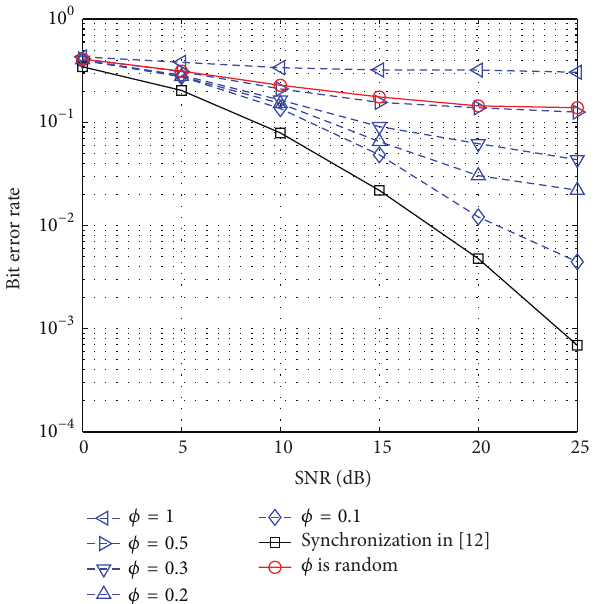
Figure 2: Effect of different imperfect synchronization coefficient 𝜙 .